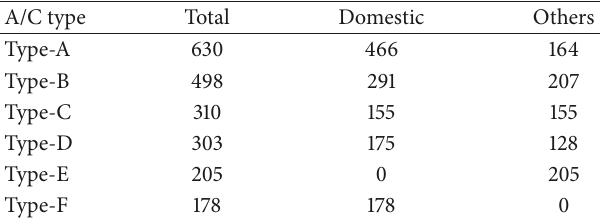
Table 2: Number of flights (July 15th,